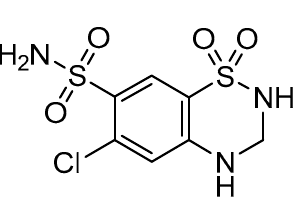
Figure 1. Structure of hydrochlorothiazide.